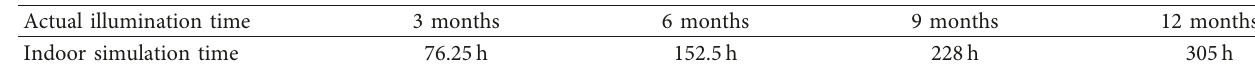
Table 2: Setting UV aging time.